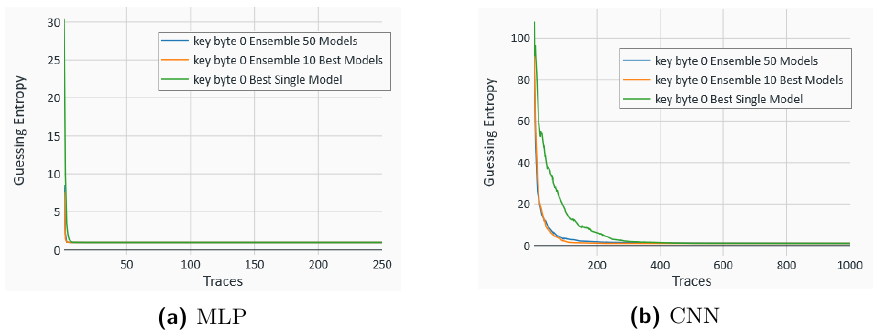
Figure 8: Guessing entropy for DPAv4 for the Hamming weight leakage